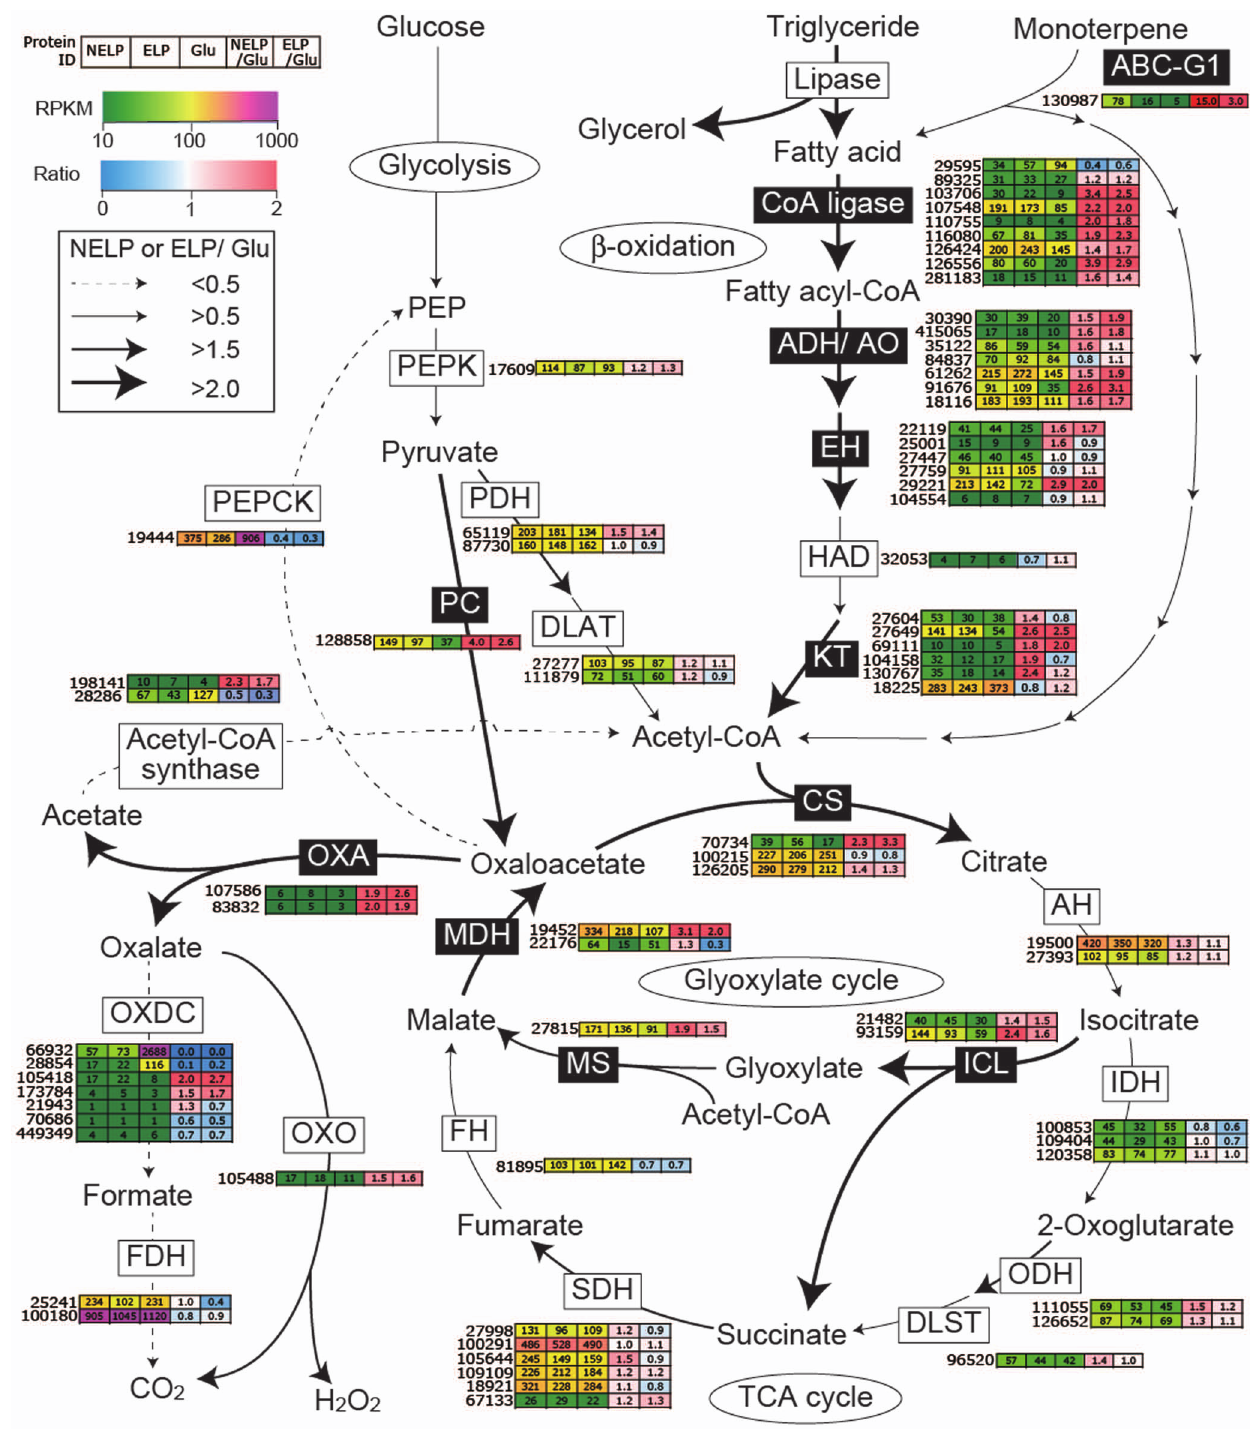
Figure 9. Glyoxalate shunt and proposed relationship to lipid oxidation when P.gigantea is cultivated on wood-containing media (ELP or NELP) relative to Glc medium. Enzymes encoded by upregulated genes are black highlighted and associated with thickened arrows. Abbreviations: ABC-G1, ABC transporter associated with monoterpene tolerance; ADH/AO, Acyl-CoA dehydrogenase/oxidase; AH, Aconitate hydratase; CoA ligase, long fatty acid-CoA ligase; DLAT, Dihydrolipoyllysine-residue acetyltransferase; DLST, Dihydrolipoyllysine-residue succinyltransferase; EH, Enoyl-CoA hydratase; FDH, Formate dehydrogenase; FH, Fumarate hydratase; KT, Ketothiolase (acetyl-CoA C-acyltransferase); HAD, 3-Hydroxyacyl-CoA dehydrogenase; ICL, Isocitrate lyase; IDH, Isocitrate dehydrogenase; MDH, Malate dehydrogenase; MS, Malate synthase; ODH, Oxoglutarate dehydrogenase; OXA, Oxaloacetase; OXDC, Oxalate decarboxylase; OXO, Oxalate oxidase; PC, Pyruvate carboxylase; PDH, Pyruvate dehydrogenase; PEP, Phosphoenolpyruvate; PEPCK, Phosphoenolpyruvate carboxykinase; PEPK, Phosphoenolpyruvate kinase; SDH, succinate dehydrogenase. See Dataset S2 for detailed gene expression data.